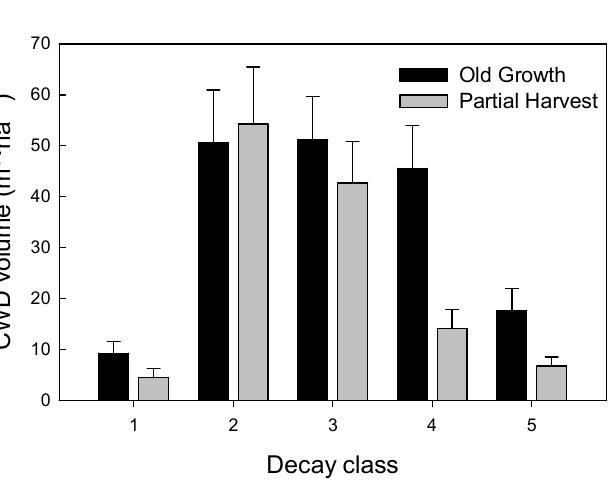
Figure 1. Decay class distributions of coarse woody debris between old-growth and partially harvested stands. Error bars represent one standard error of the mean. CWD: coarse woody debris.